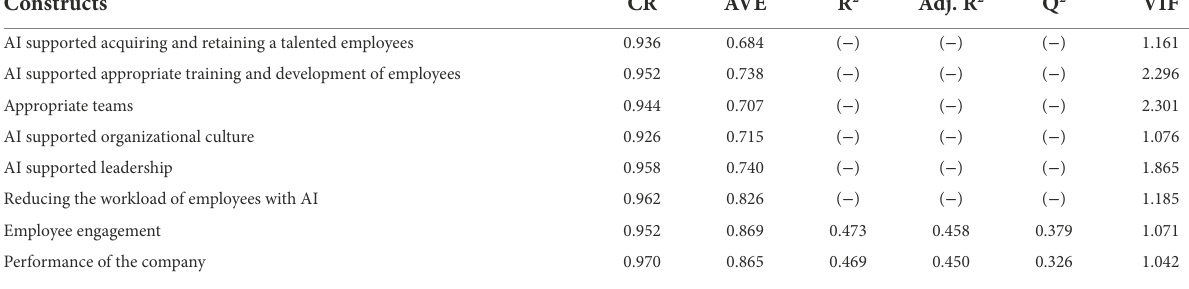
TABLE 4 Indicators of quality of the structural